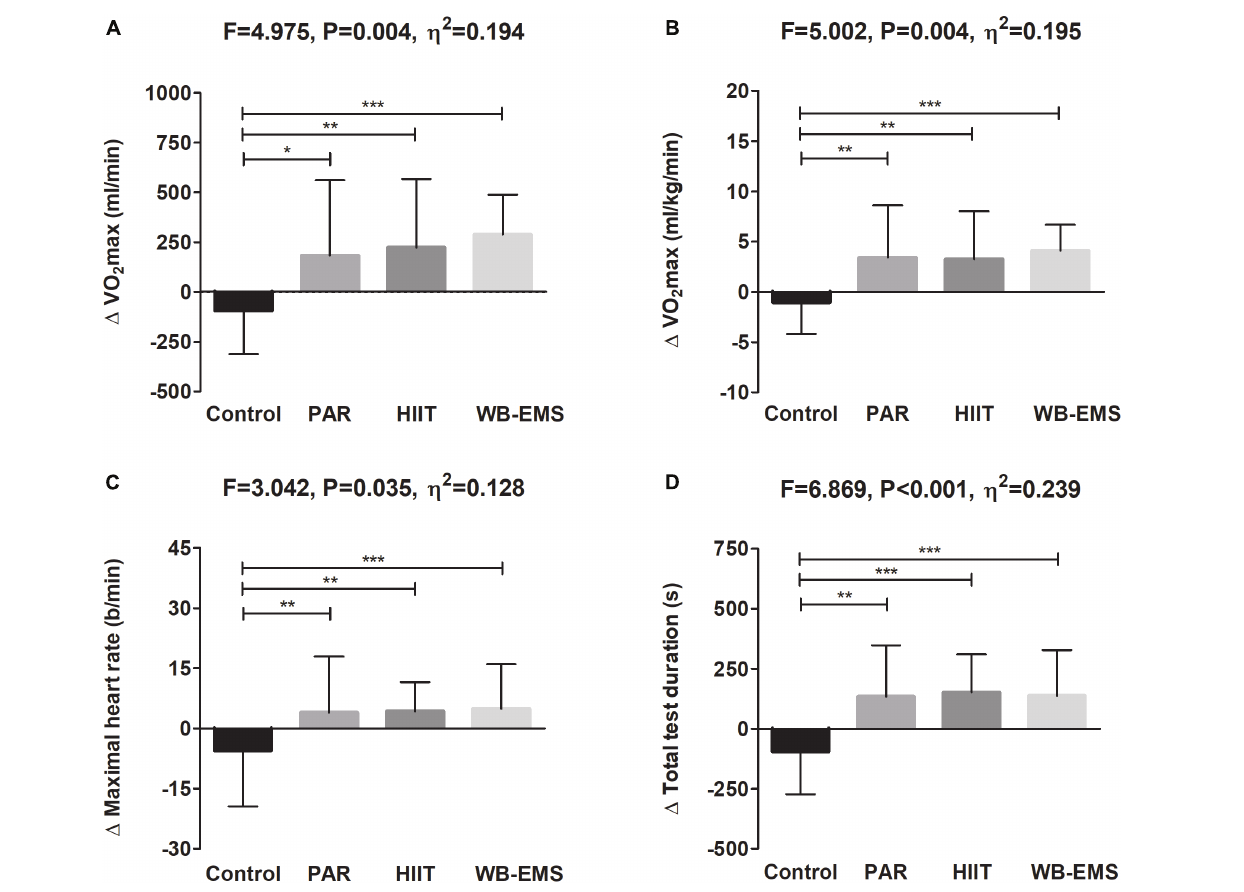
FIGURE 5 | Changes in maximum oxygen uptake (VO 2 max) in absolute (A) and relative terms (B) , maximal heart rate (C) , and total test duration (D) after the intervention study among the four groups. Data are shown as means ± standard deviation. Parallel bars indicate significant differences between groups applying an analysis of covariance adjusting by baseline values, with post hoc Bonferroni-corrected t -test ( ∗ P < 0.05, ∗∗ P < 0.01, ∗∗∗ P < 0.001). PAR, physical activity recommendations for adults proposed by the World Health Organization group; HIIT, high intensity interval training group; WB-EMS, whole-body electromyostimulation group.